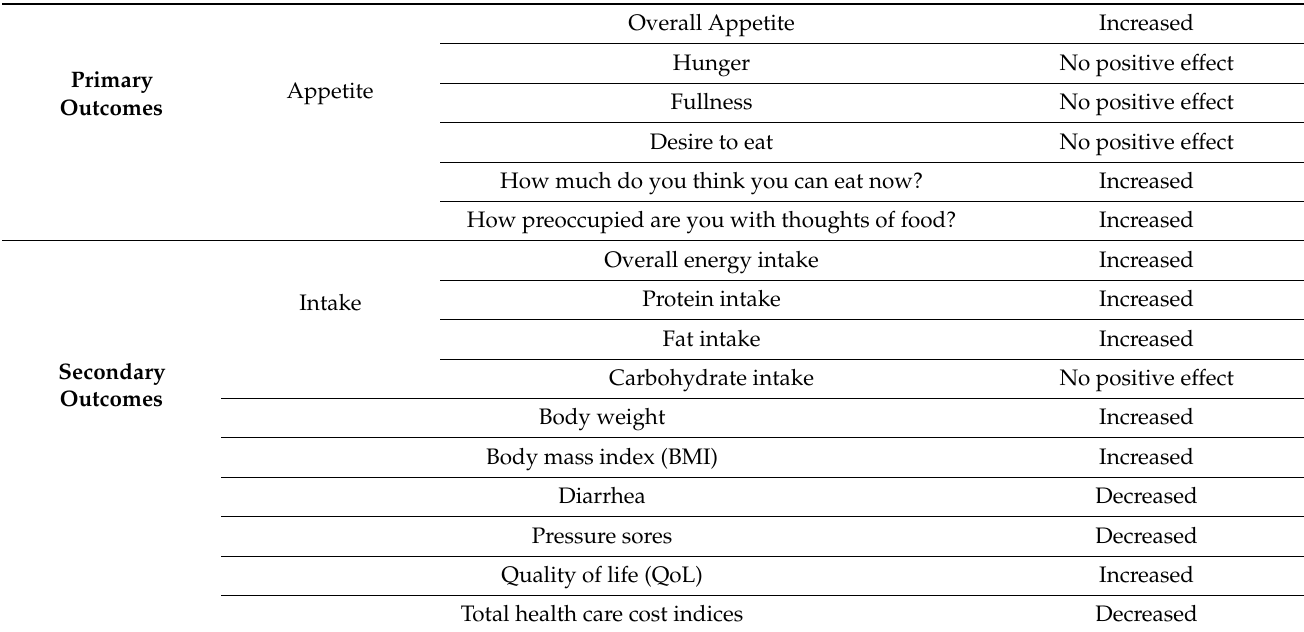
Table 3. The overall effect of the oral nutritional supplements (ONS) on the included